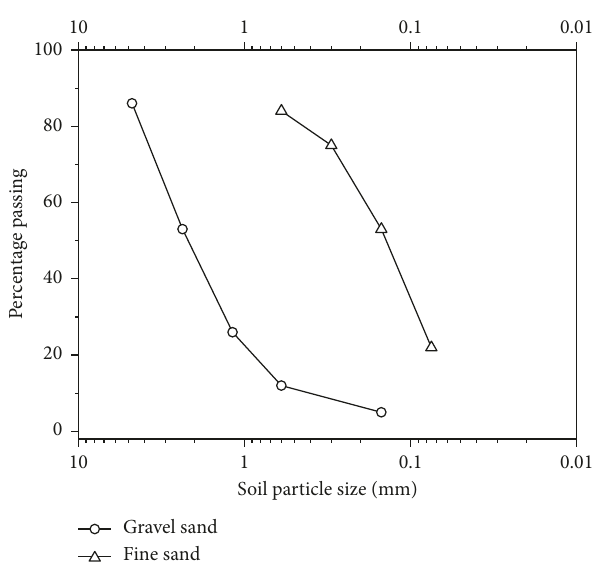
Figure 4: Particle-size distributions of soil in the model test.